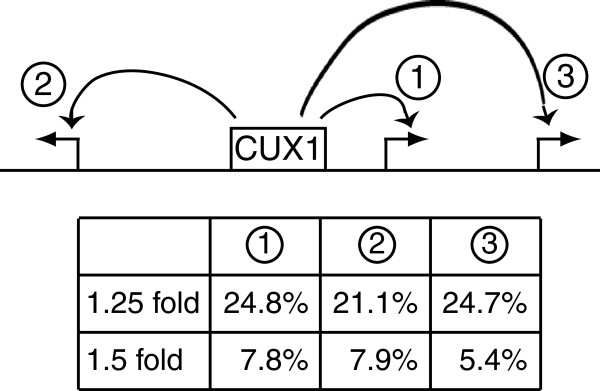
Relationship Between Gene Position and Regulation by CUX1. Three
types of situations are depicted in the diagram. 1, genes that are the
closest to the CUX1 binding site; 2, genes that are further away and in
the other direction from the CUX1 binding site; 3, genes that are
located further away and are separated by another gene from the CUX1
binding site. For each category, the table shows the percentage of genes
that exhibit a 1.25 or 1.5 change in expression following p110 CUX1
overexpression or CUX1 knockdown.